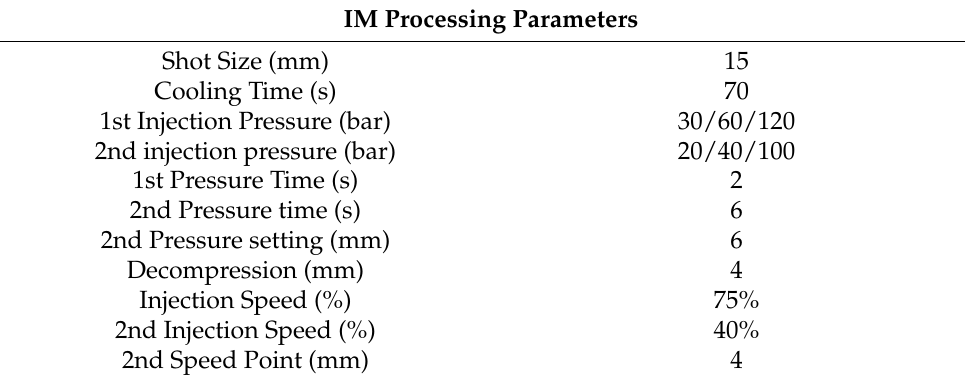
Table 3. The parameters of injection molding and overprinting process. 3DP Infill Percentage